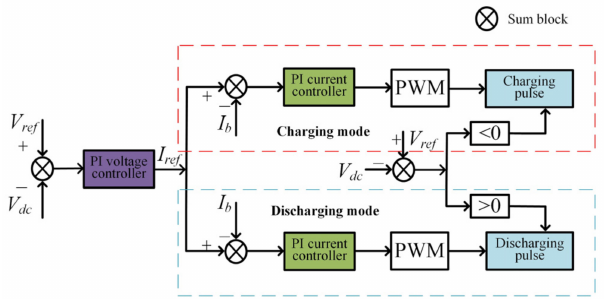
Figure 4. Bidirectional DC–DC converter control block diagram of